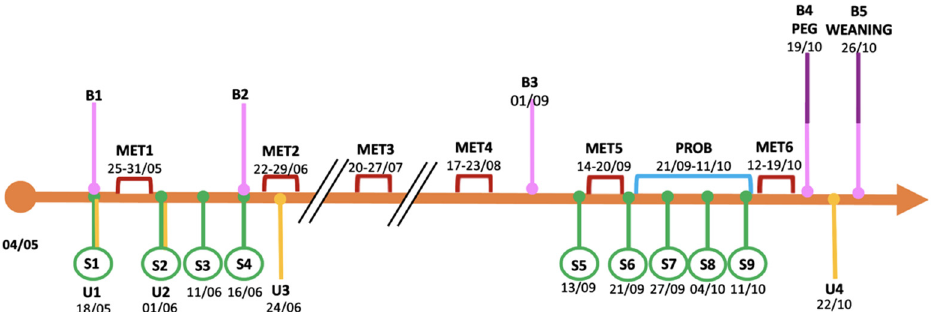
Figure 1. Experimental design of the study. B: blood sample; S: stool sample; U: urine sample; MET: metronidazole treatment; PROB: probiotic supplementation; PEG: percutaneous endoscopic gastrostomy. Months referred to year 2020.